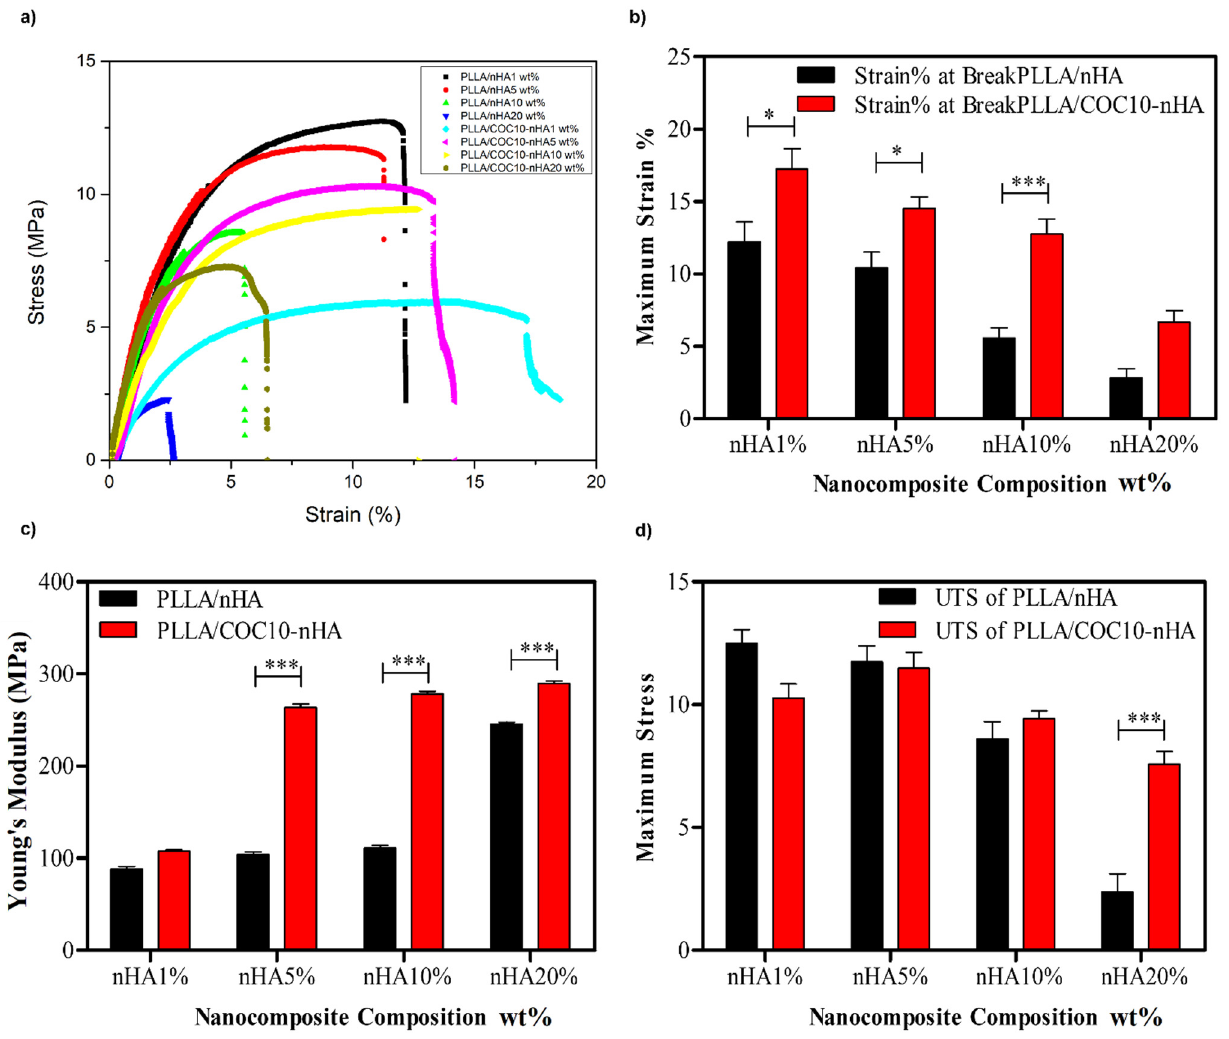
Figure 5. Tensile mechanical properties of the PLLA/COC10-nHA and PLLA/nHA nanocomposites. ( a ) Stress-strain curves of nanocomposites. ( b ) Ultimate tensile strength of nanocomposites. ( c ) Young’s modulus of nanocomposites. ( d ) Elongation at break of nanocomposites. Nanocomposites had nHA in 1 wt%, 5 wt%, 10 wt%, and 20 wt%. Data is statistically significant (error bars: ± SD, * p < 0.05, ** p < 0.01, and *** p <